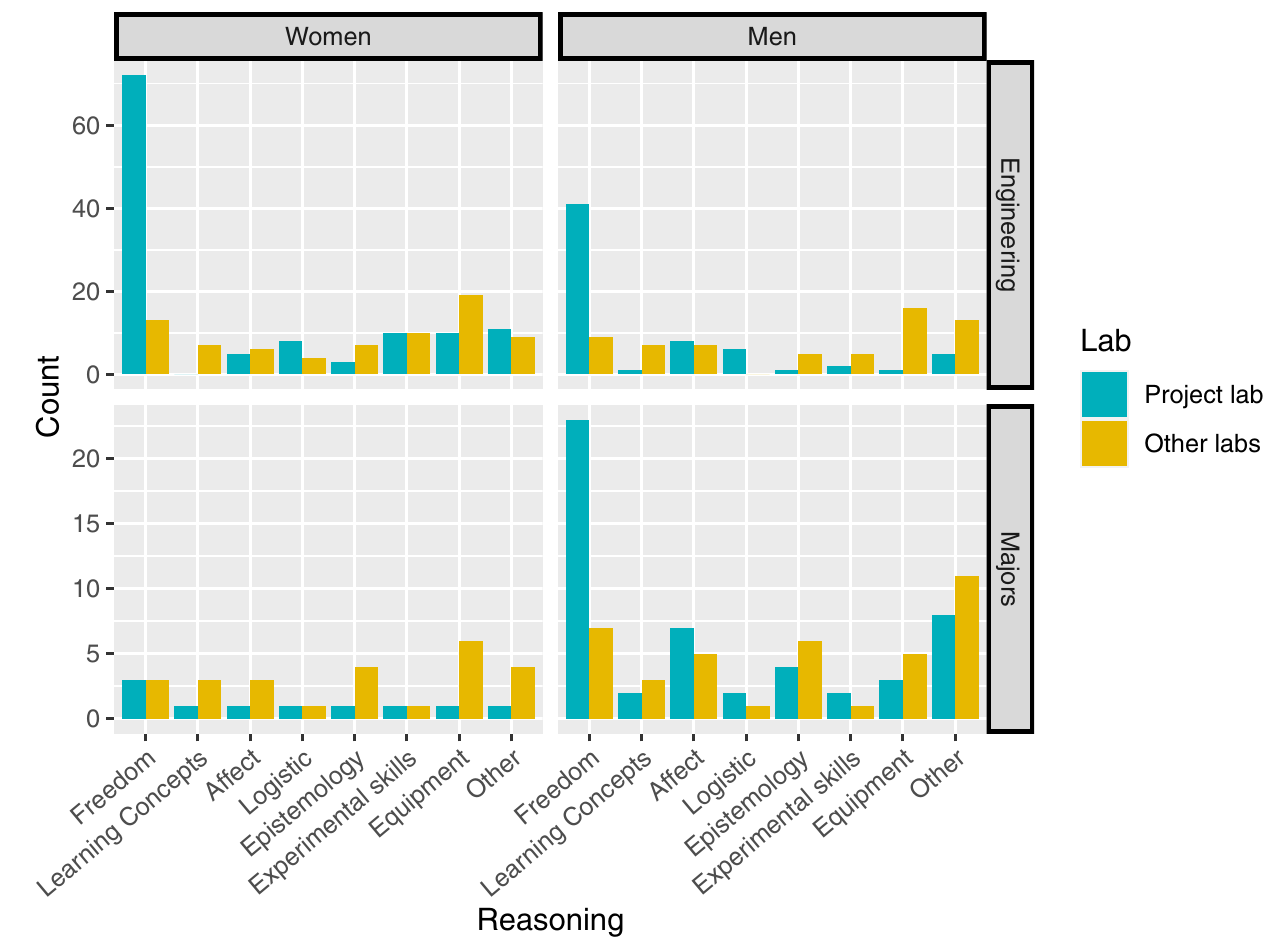
FIG. 4. Coding results of physics and engineering students ’ reasoning to their preferred lab unit. Students ’ responses could be coded under multiple reasoning